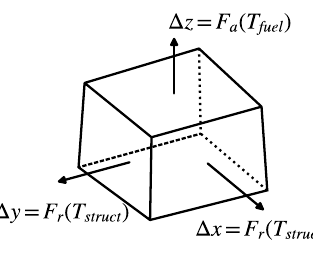
Figure 3: Thermal Expansion of a General